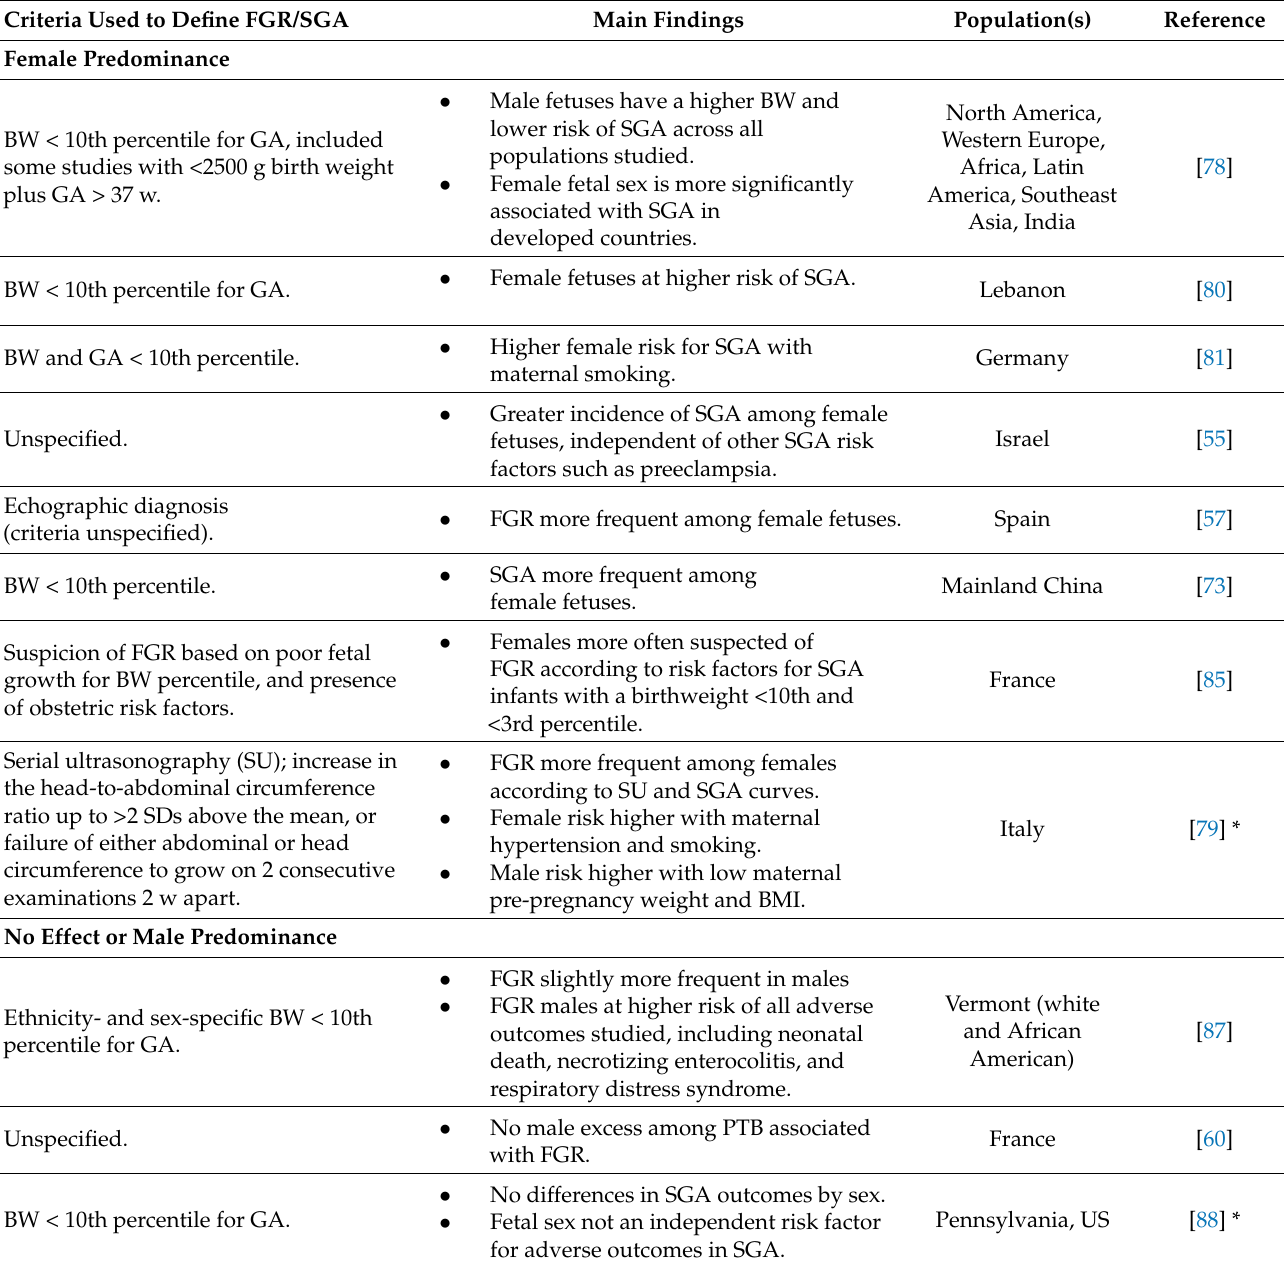
Table 2. Summary of findings from fetal growth restriction (FGR) and small for gestational age (SGA) studies, PTB indicates pre-term birth. An asterisk (*) indicates n FGR < 1000 or n SGA < 1000. Criteria Used to Define